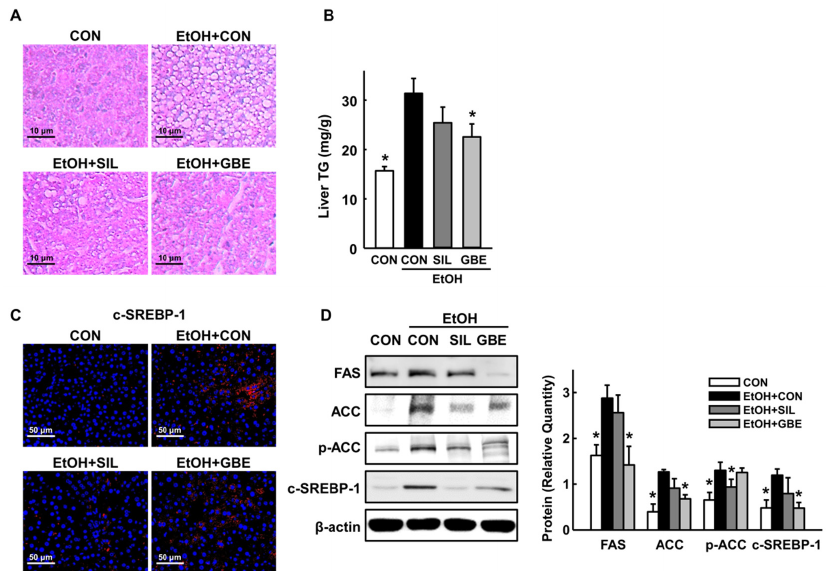
Figure 1. Protective effects of GBE against alcohol-induced hepatic steatosis . ( A ) Representative hematoxylin and eosin (H&E) staining of the liver, ( B ) Liver triglyceride (TG) contents, ( C ) Representative immunohistochemical staining for hepatic cleaved sterol regulatory element-binding protein 1 (SREBP-1) (red), ( D ) Western blot of hepatic fatty acid synthase (FAS), acetyl-CoA carboxylase (ACC), phospho-ACC (p-ACC), and cleaved SREBP-1 expression with quantitative data. CON, control; SIL, silymarin; GBE, water extract of G. bimaculatus . Data are shown as means ± SEM ( n = 4 for A and C and n = 8 for B and D). * p < 0.05 vs. EtOH control group.